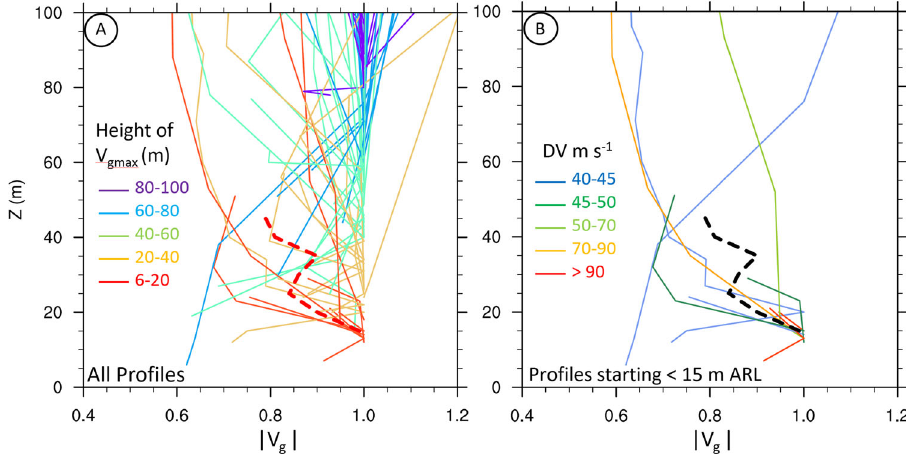
Fig. 2 Normalized windspeed |V g | pro fi les observed by DOWs. V g normalized by V gmax observed <100 m AGL. Dashed lines: median pro fi le from the 2012 Russell, KS tornado 27 . A All pro fi les containing observations <100 m ARL. Line colors are height of V gmax in each pro fi le. B Only pro fi les containing observations <15 m ARL. Line colors are DV observed at lowest level in each pro fi